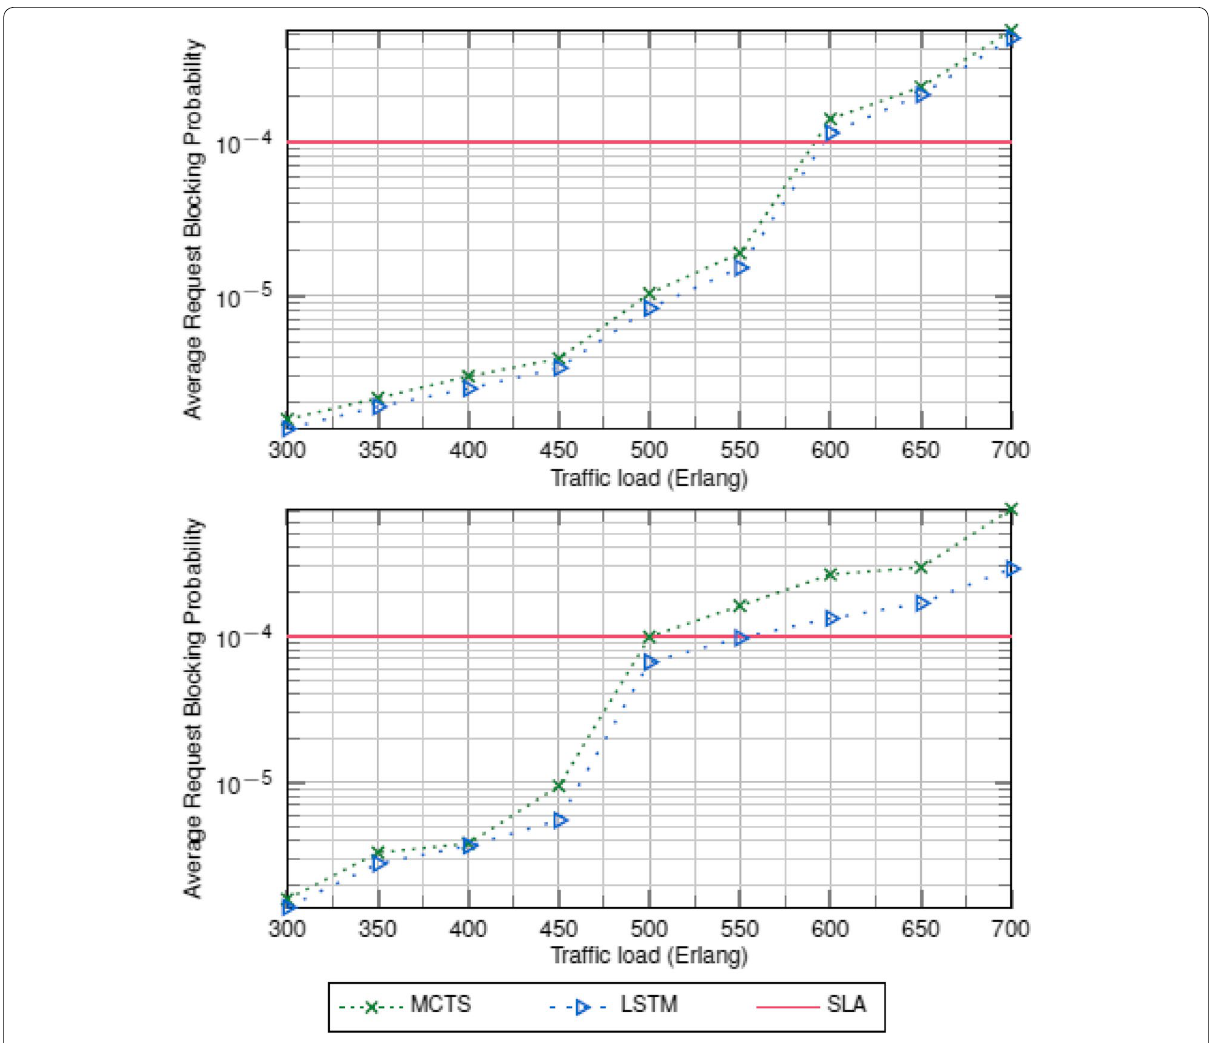
Fig. 7 Scenario #3: Euro28 (on top) and US26 (bottom)